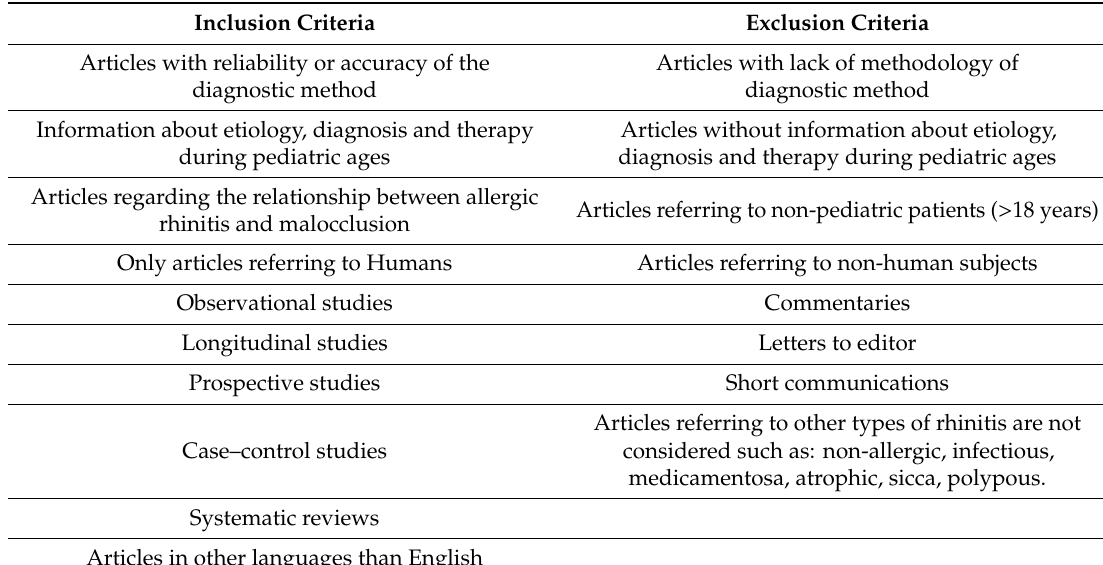
Table 1. Inclusion and exclusion